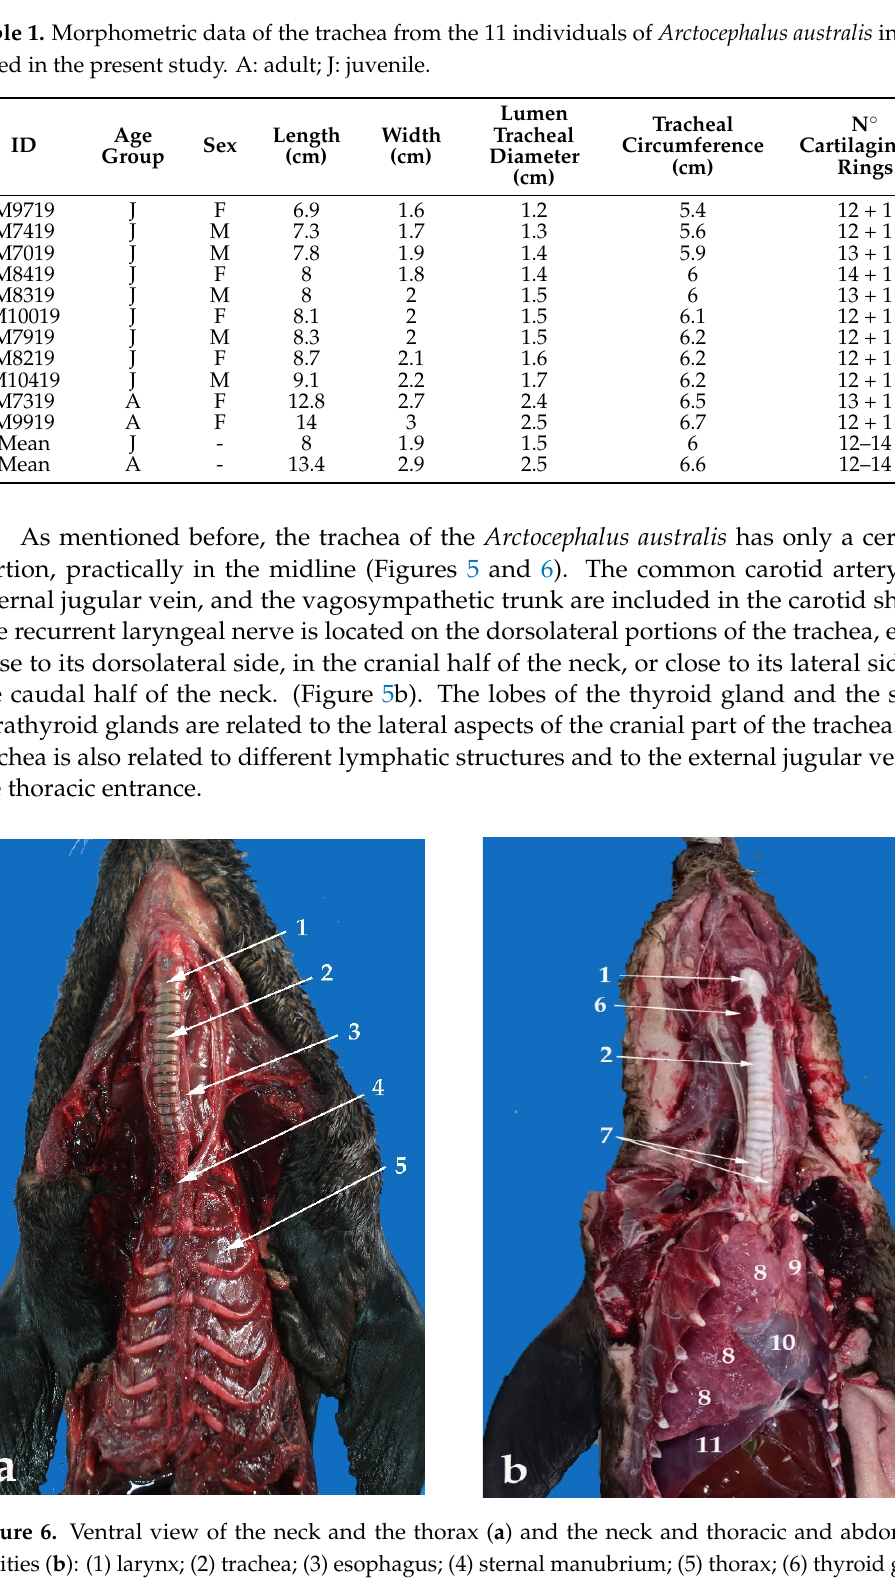
Figure 7. Trachea section, ventral view: (1) cartilaginous rings; (2) membranous part. The diameter of the tracheal lumen is 1.5 cm in juveniles and 2.5 cm in adults, whereas the tracheal circumference is about 6 cm in the former and 6.8 cm in the latter (Table 1). 3.6. Bronchi As previously described, the trachea of the South American fur seal early bifurcates into the two main bronchi at the level of the caudal third of the neck, practically at the